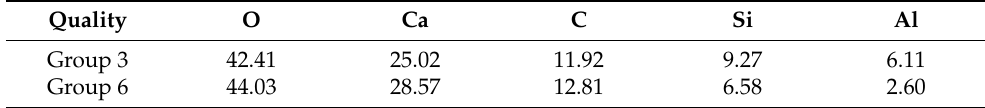
Table 10. Quality of main elements